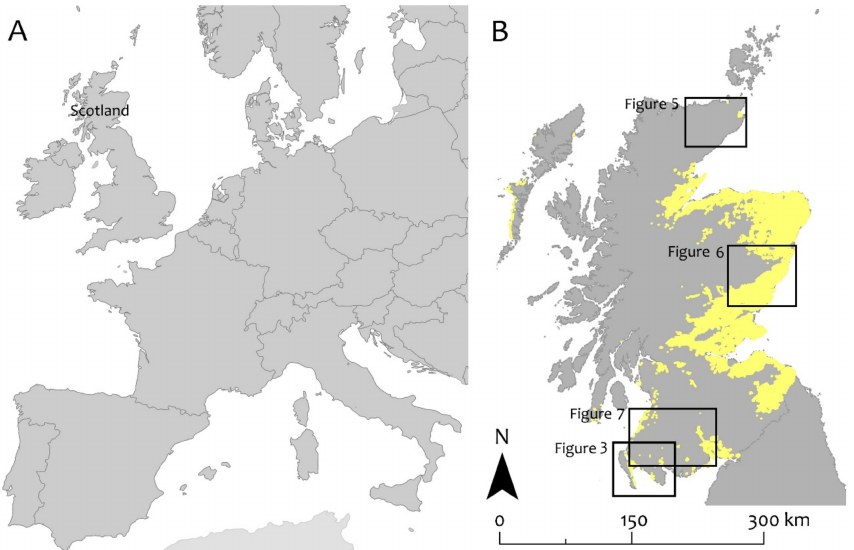
Figure 2. ( A ) The location of the study area in north-west Europe. ( B ) Map of Scotland, with yellow tone indicating the generalised extent of arable ground, which is a specific focus of interest for repeat imaging. The locations of Figures 3, 5, 6 and 7 are shown, referring to issues discussed